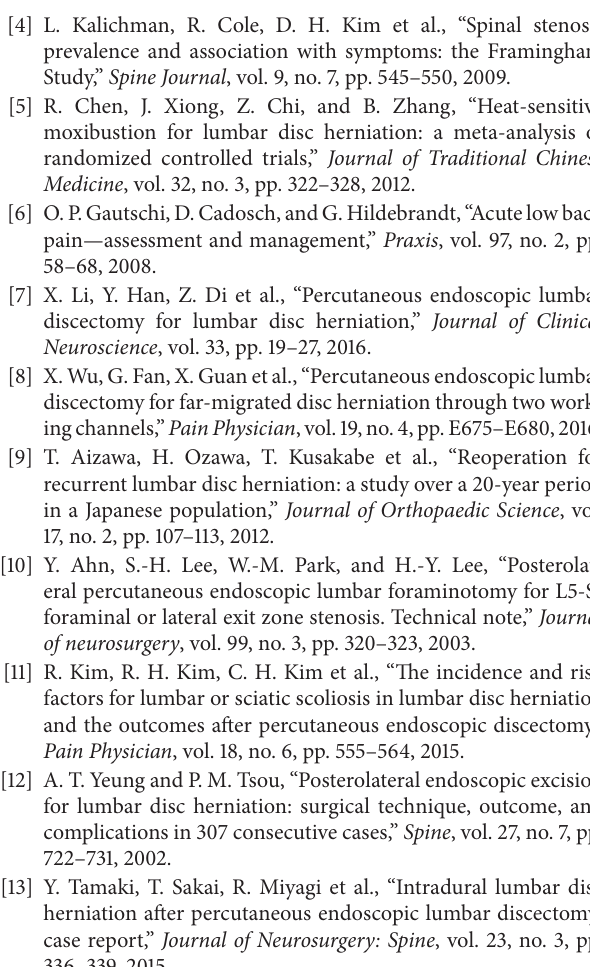
treatment for patients diagnosed by lumbar scoliosis with LSS and LDH, but we also need a larger-sample study with long- term follow-up in this